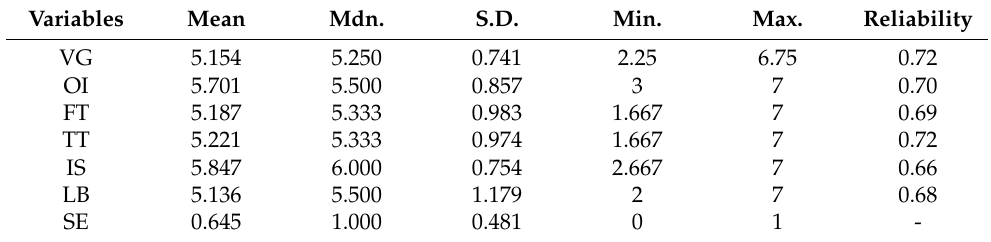
Table 2. Descriptive statistics of the